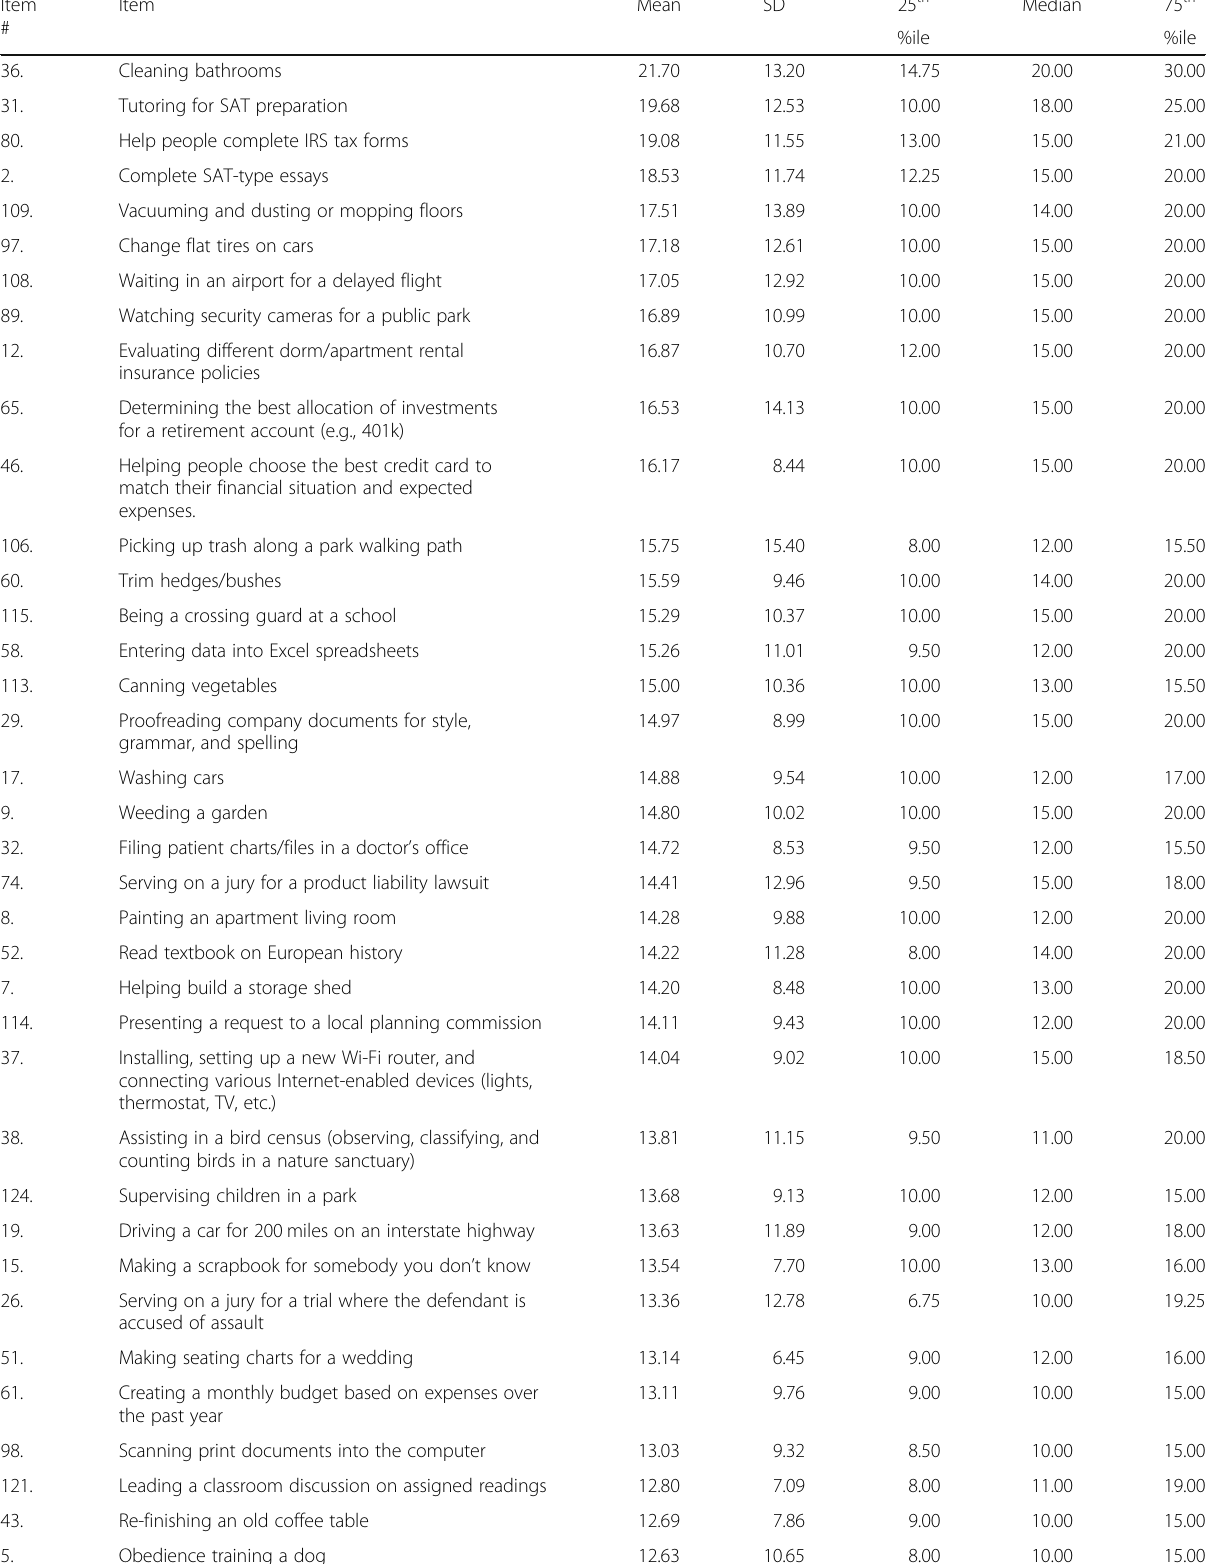
Table 1 Disutility judgments. Task items and descriptive statistics (mean, SD, 25%ile, median,